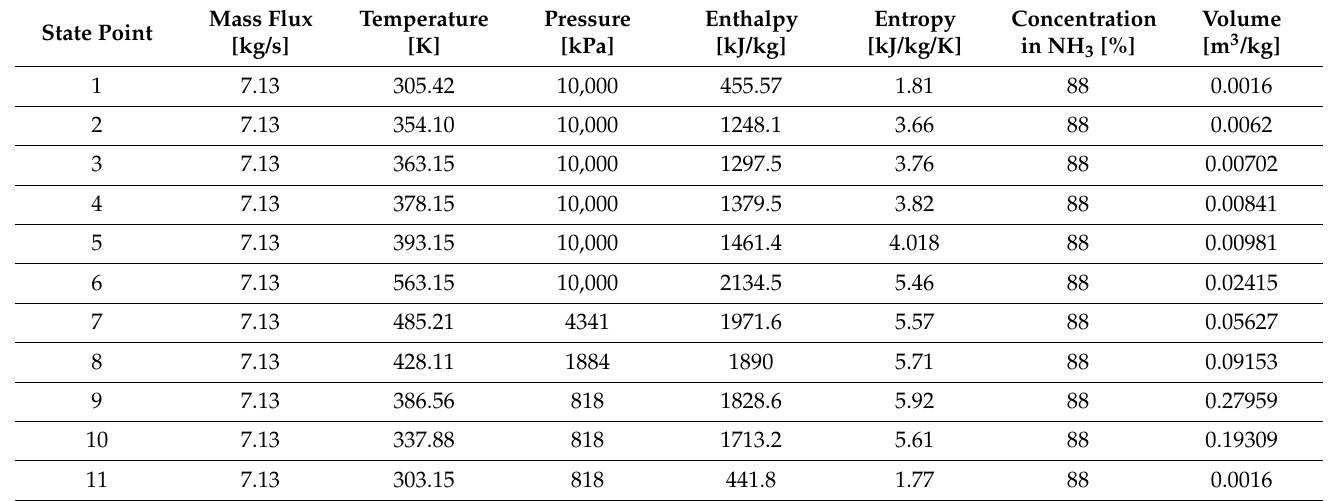
Table 9. Thermodynamic properties of KCB system